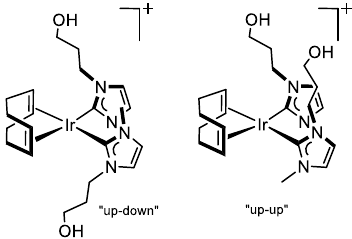
Figure 12. Diastereomers of complex 9 .